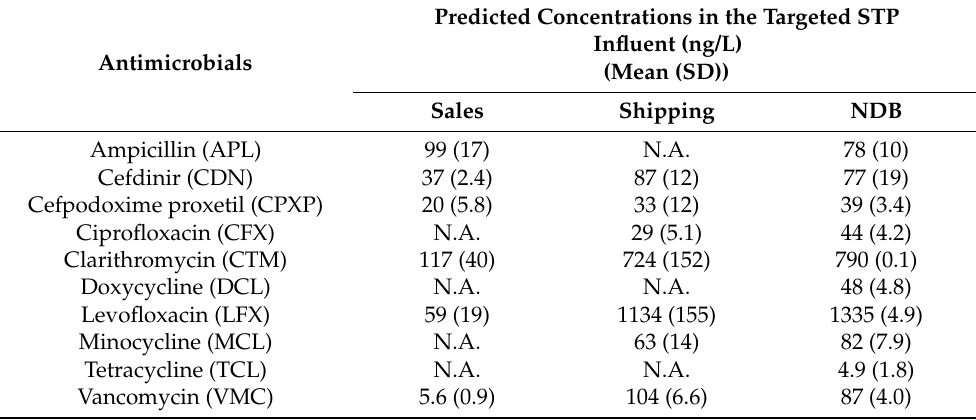
Table 4. Predicted concentrations of antimicrobials in the target STP influent. Antimicrobials